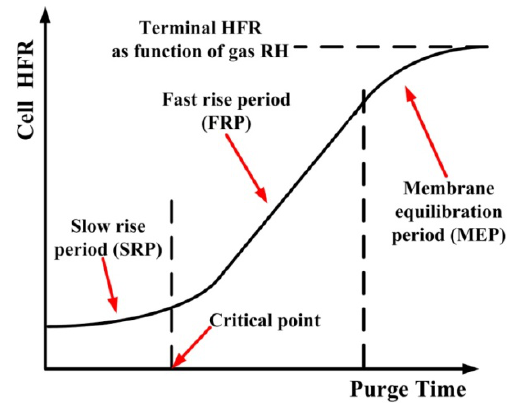
Figure 8. Stages of gas purging